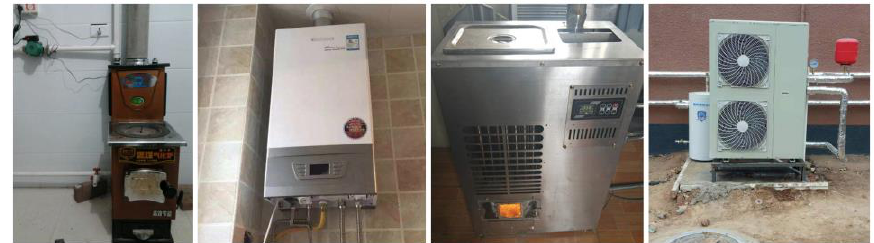
Figure 5. Cleaner decentralized heating solutions for rural north China, from left to right: shaped coal boiler; gas boiler; biomass boiler; ASHP (data source: the author [61]). Except for the cleaner heat sources, the demand side improvements are also